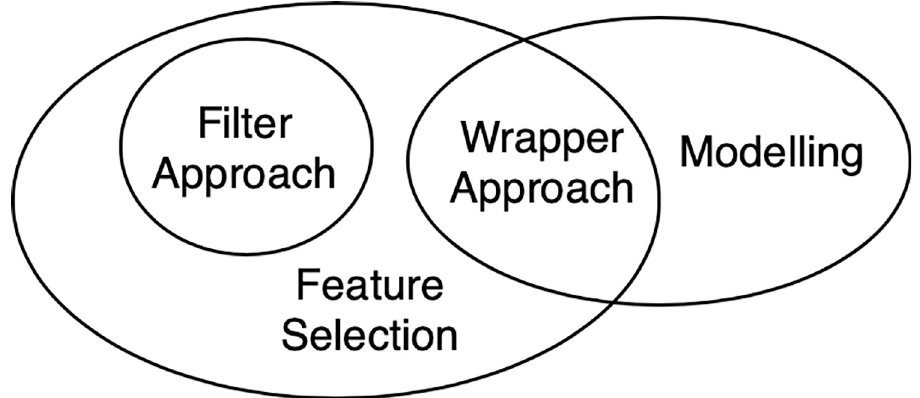
Fig 3. The relationship for feature selection and